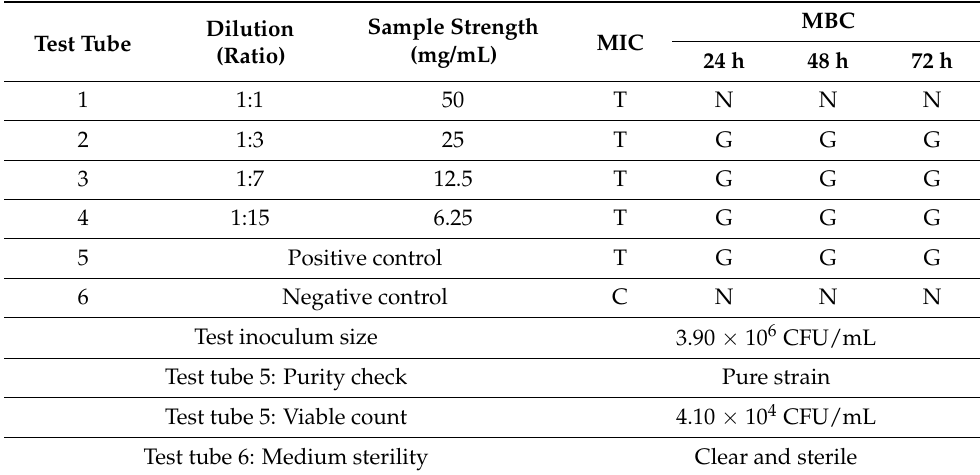
Table 2. MIC and MBC assays of nanotitania against Klebsiella pneumoniae ATTC